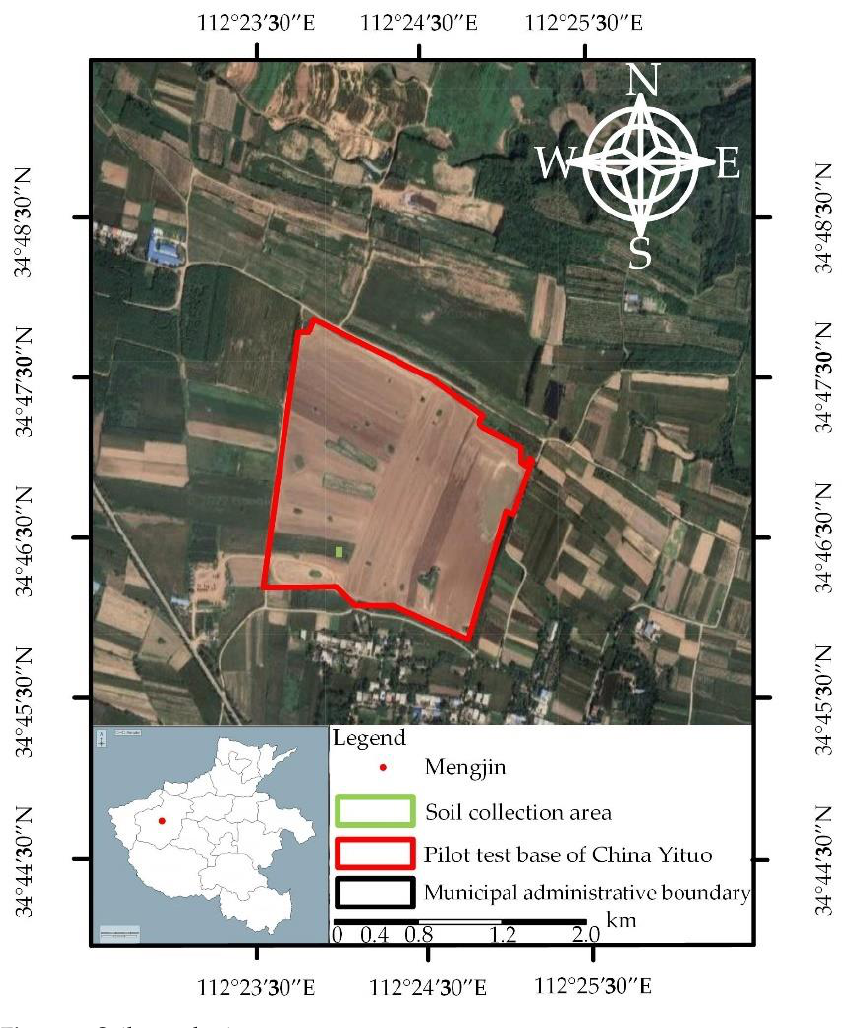
Figure 1. Soil sample site. Table 1. Particle size